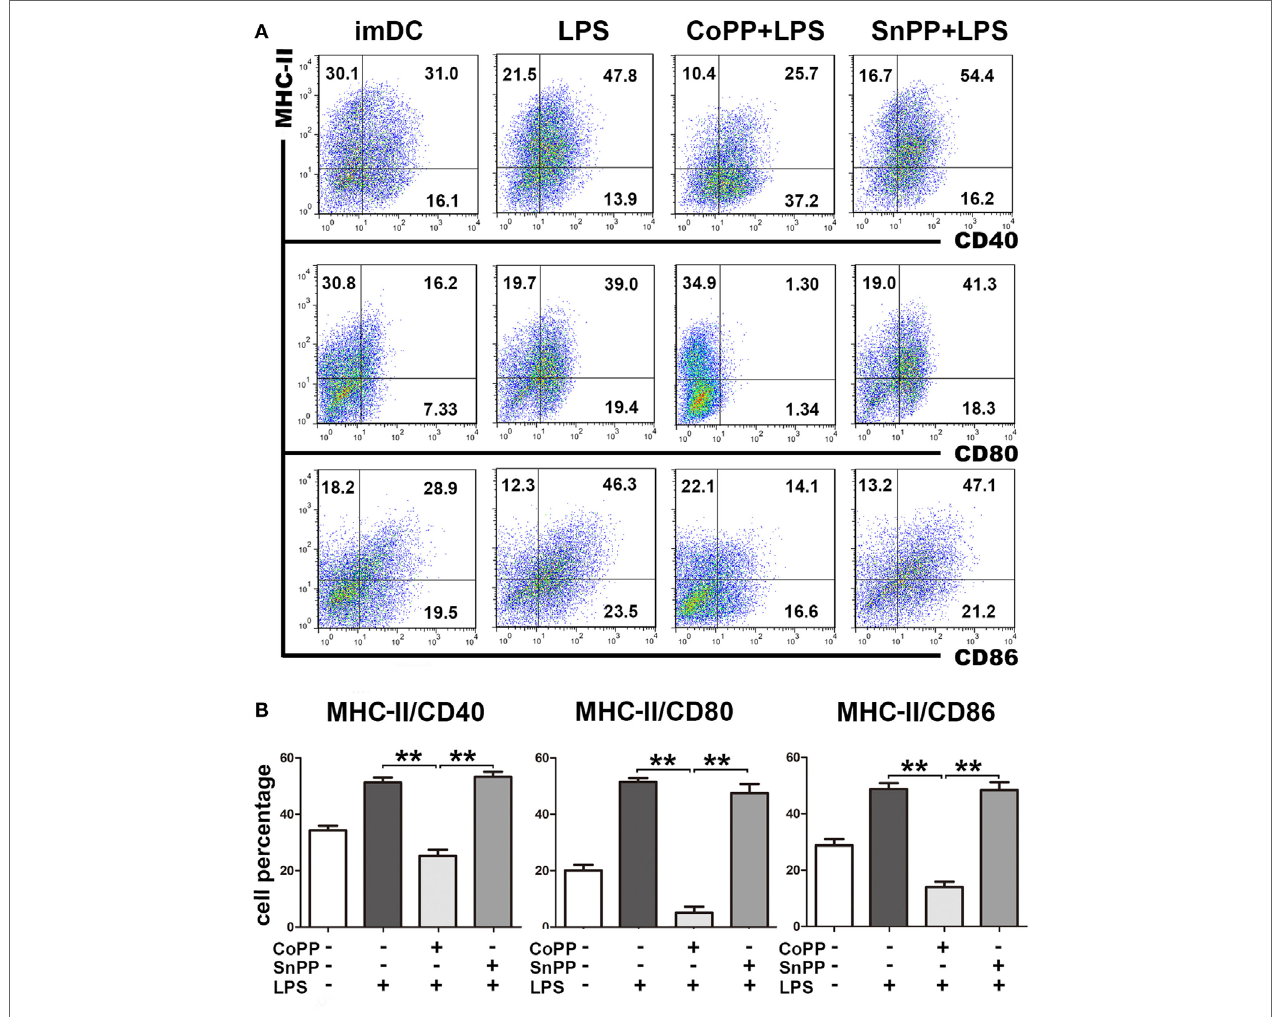
FigUre 2 | Upregulation of heme oxygenase-1 renders immature dendritic cells (imDCs) refractory to lipopolysaccharide (LPS)-induced maturation. Untreated, cobalt protoporphyrin-pretreated, or SnPP-pretreated imDCs were incubated with LPS to induce maturation for 24 h. Untreated imDCs without LPS stimulation were used as controls. The expression of MHC-II, CD40, CD80, and CD86 was assessed by FACS analysis. (a) Representative FACS results of three independent experiments. Numbers in quadrants indicate the percentage of positive cells. (B) Quantitative assessment of the percentages of MHC-II/CD40, MHC-II/CD80, and MHC-II/CD86 double-positive cells. The data shown are means ± SD ( n = 3 per group; ** P <